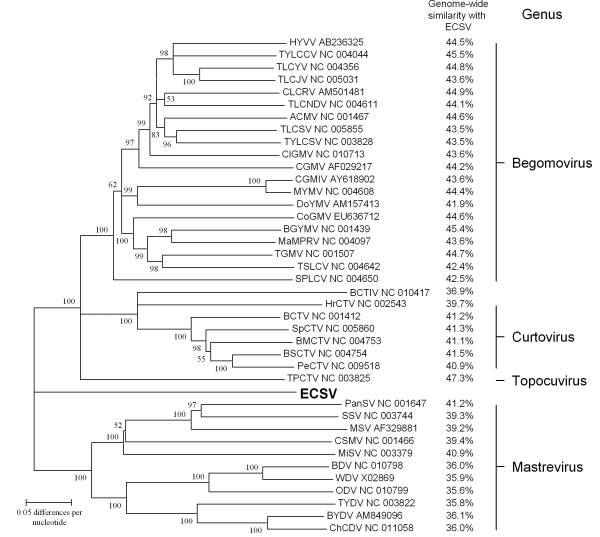
Degrees of genome-wide sequence identity shared between ECSV (in bold; isolate ECSV [Za-Gre3-g257-2007]) and 40 representative geminivirus genomes (or DNA-A or DNA-A like genome components in the case of the begomoviruses; virus names and GenBank accession numbers are given in the tree). Note that due to (i) recombination during the evolutionary histories of many of the represented viruses (ii) very high degrees of alignment uncertainty and (iii) the strong possibility that many regions of the aligned genomes are not homologous, the presented neighbour joining tree is simply intended as a graphical depiction of genome-wide nucleotide sequence identities rather than a credible representation of the evolutionary relatedness of these viruses. Numbers associated with tree branches indicate percentage of bootstrap support (from 1000 replicates) for those branches. Branches with less than either 50% bootstrap support or less than 90% interior branch length test support (as determined in MEGA 4.0) have been collapsed. The percentage genome-wide nucleotide sequence identities shared between ECSV and the other geminivirus genomes (with alignment gaps treated as missing data rather than a fifth character state) is presented on the right.